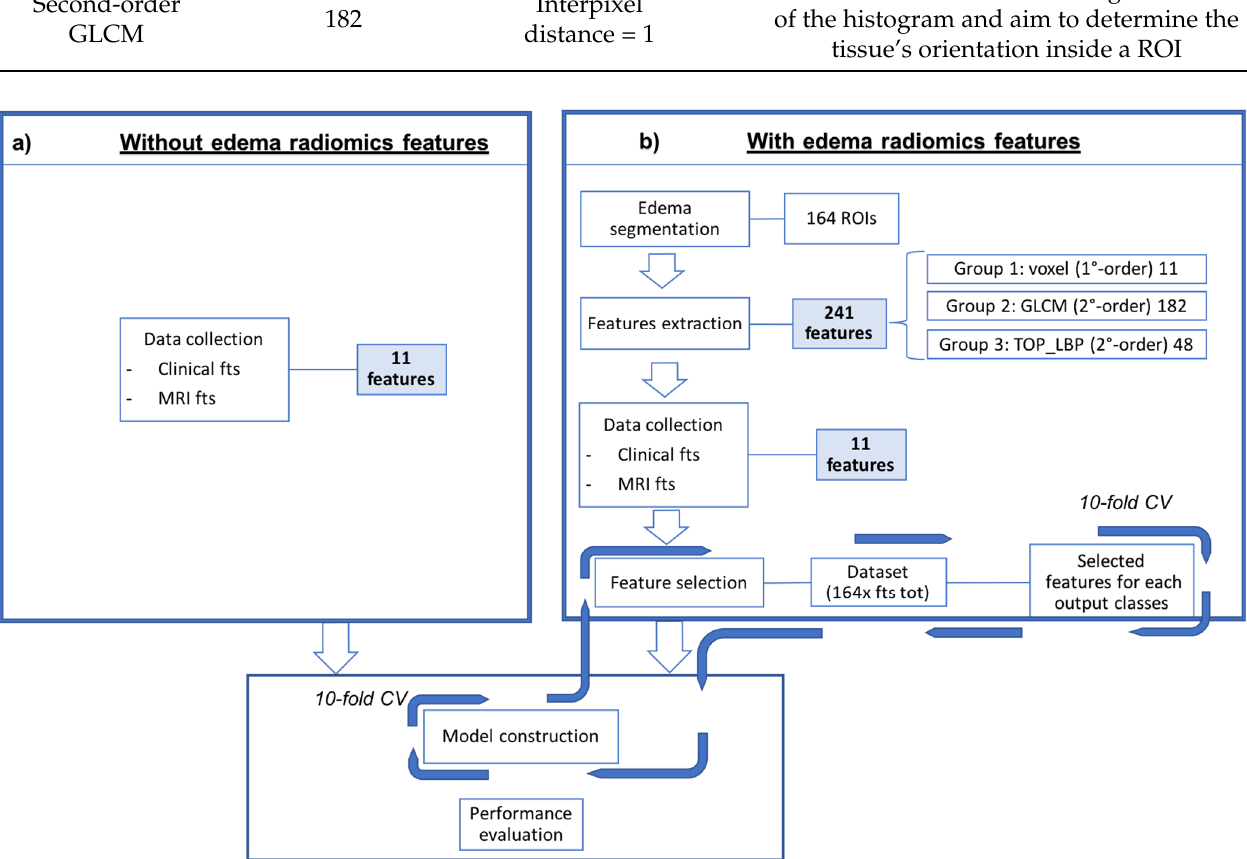
Figure 2. Schematic representation of the proposed approach to predict the five histological labels. In the left bow ( a ) is reported the classic medical approach, using only the semantic features, while in the right box ( b ) the classification was performed associating the radiomics features to the semantic ones. The model is then built using the best performing features.